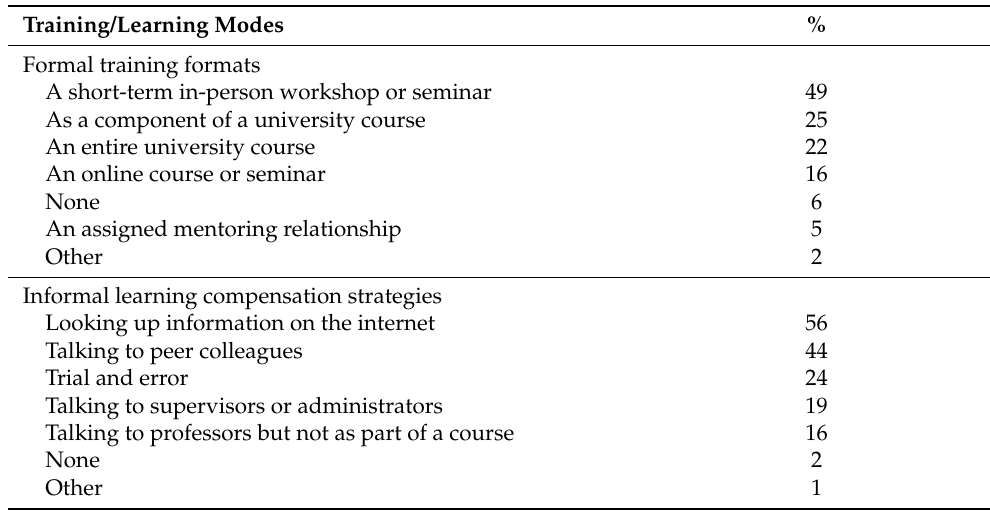
Table 3. Training